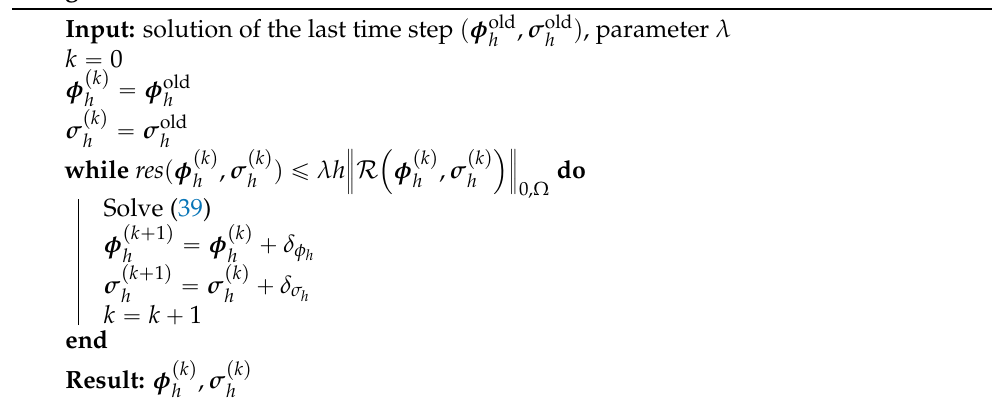
Algorithm 1: Gauss-Newton for minimization of the nonlinear